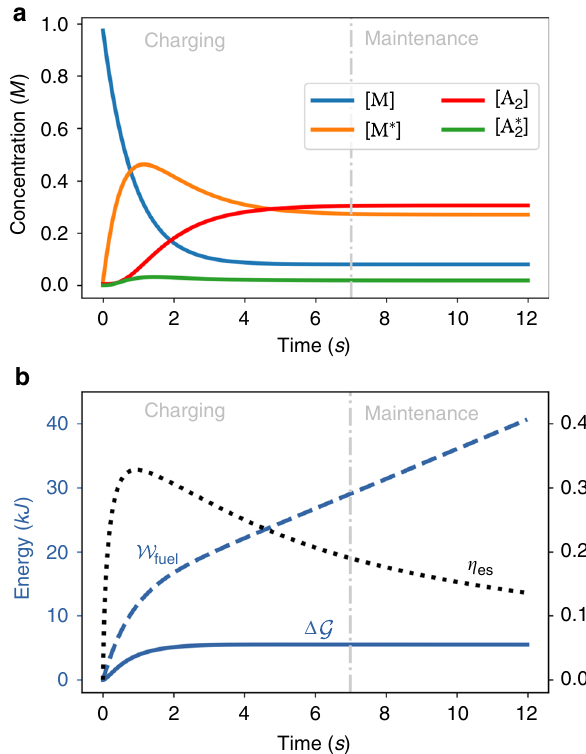
Fig. 2 Dynamics of energy storage. The system is initially prepared at (cid:6) ½ A (cid:4) thermodynamic equilibrium where ½ M (cid:4) . At time t = 0, the 2 eq eq chemical potential difference between fuel and waste is turned on at F ¼ 7 : 5 (cid:7) RT and drives the system away from equilibrium. After a fuel transient (charging phase), the system eventually settles into a nonequilibrium steady state (maintenance phase). a Species abundances. b Energy stored, work and ef fi ciency (right axis, adimensional units). Kinetic constants ({ k ± ρ }) and chemical potentials used for simulations are given in